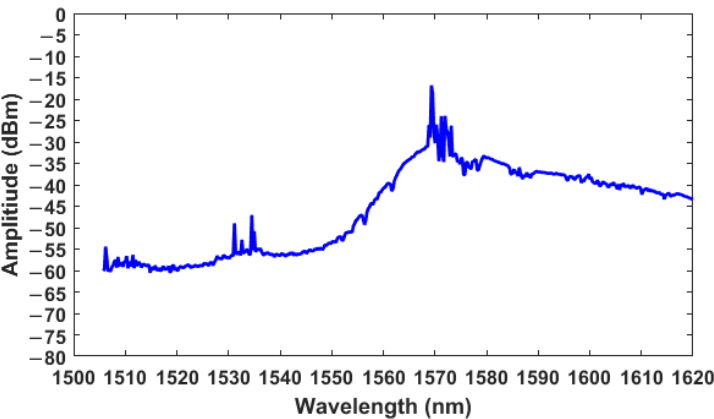
Figure 2. Free-running modes of the proposed laser cavity at the maximum pump power of 450 mW. The threshold power for the generated sextuple Stokes signals is illustrated in Figure 3.